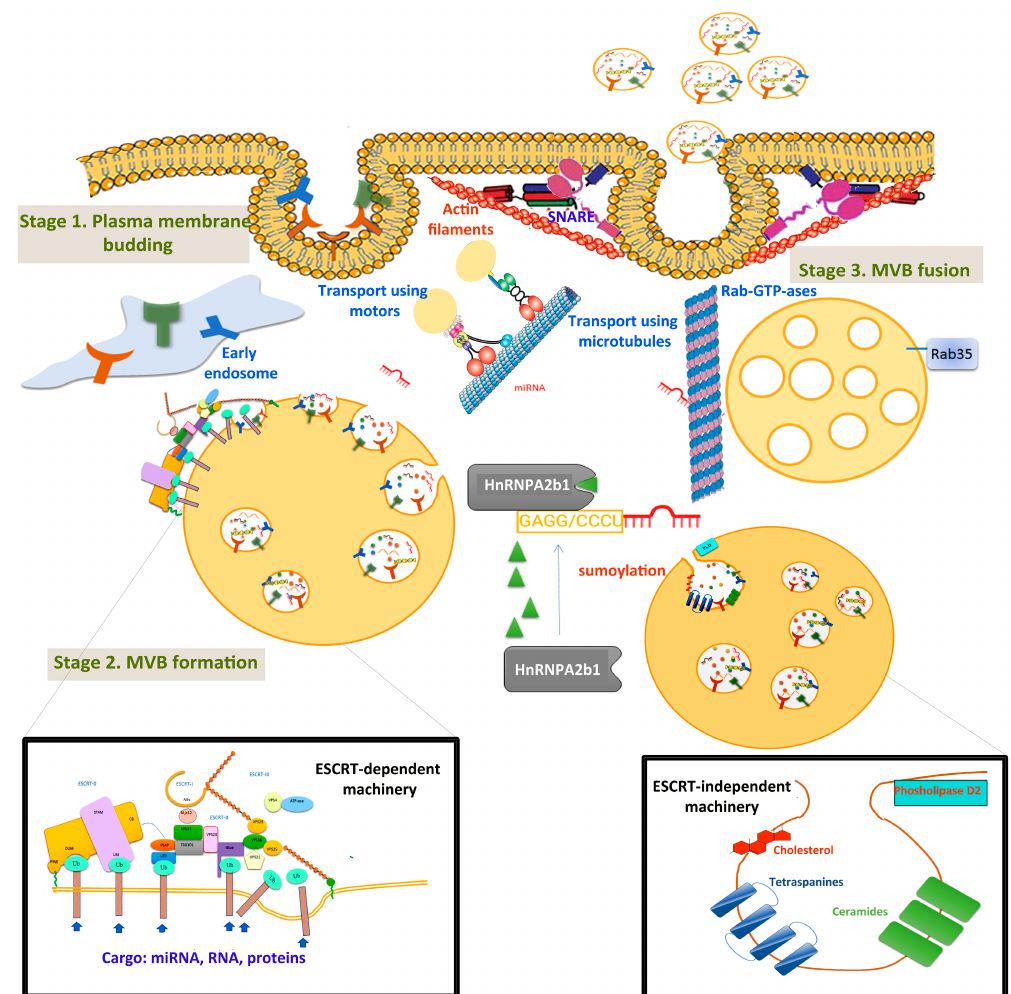
Figure 1 Figure 1. Extracellular vesicles’ biogenesis, transport, and membrane fusion. The first stage, membrane budding, integrates receptors that are transferred into early endosomes. MVB formation (stage 2) and sorting take place in the late exosome. De- tailed ESCRT-dependent and ESCRT-independent pathways are presented in insets. MVBs are transported via microtubules and motor proteins, and fuse with the cellular membrane using SNARE, synaptotagmin proteins, and actin filaments. The pathway proposed for miRNA sorting using sumoylated HnNPA2b1 protein is also